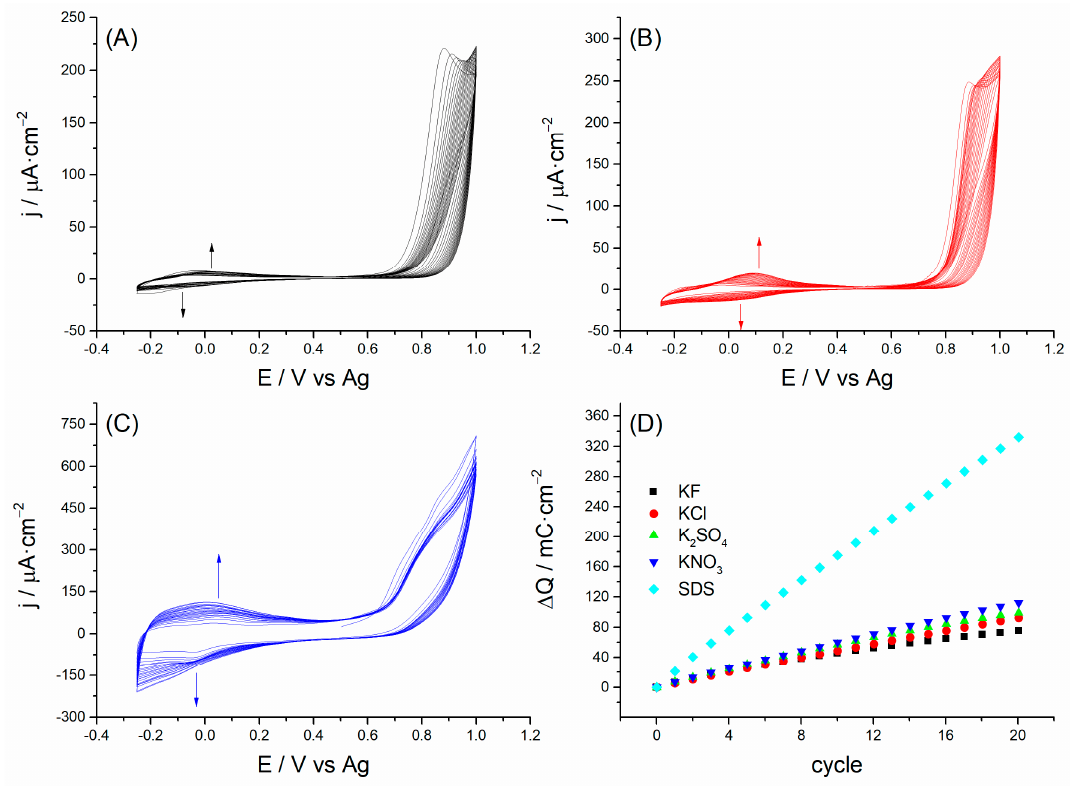
Figure 1. Polarization curves of 1 mg · mL − 1 azure A in 0.02 M KF ( A ), K 2 SO 4 ( B ) and SDS ( C ) aqueous solutions at a scan rate of 10 mV · s − 1 between − 0.25 V and 1 V. The voltammetry cycle starts at 0.5 V. ( D ) Charge accumulation during the electrochemical reactions of PAA(anion) electrosynthesis calculated from the voltammetric cycles shown in ( A – C ) and Figure S1.